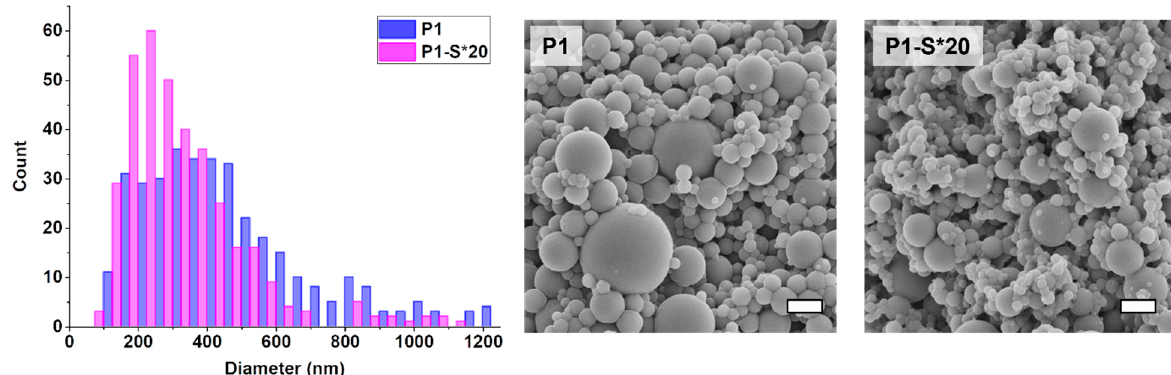
Figure 4. Size distribution histogram ( left ) as a function of particle diameter and particle count (graphed using image analysis of SEM micrographs) and corresponding SEM images of the polymer nanoparticles produced from solutions P1 and P1-S*20 ( right ). Scalebar—1 µm .